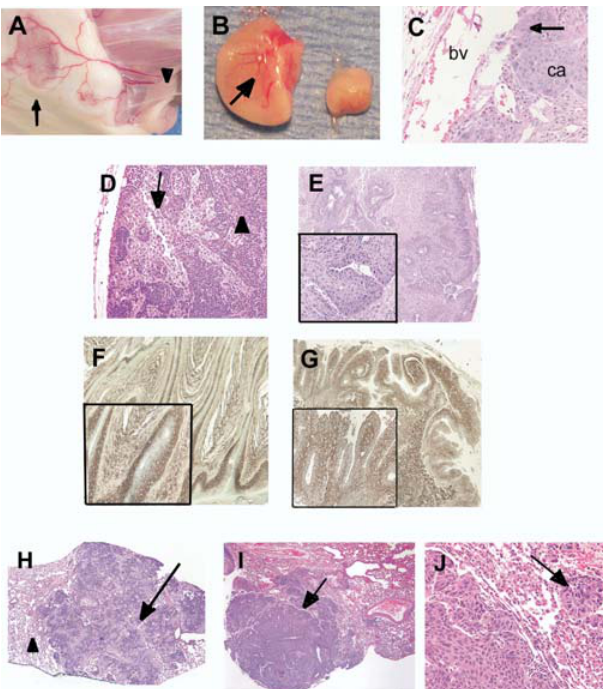
Figure 2. Metastasis of Primary SCC to Lymph Nodes and Lungs in p19 Arf -Deficient Mice (A) Underside of skin from tumor-bearing mouse shows newly formed blood vessels surrounding tumor site (arrow) and leading to inguinal lymph node (arrowhead). (B) Enlarged inquinal lymph node (left) containing metastatic SCC and blood vessel formation (arrow) compared to normal lymph node